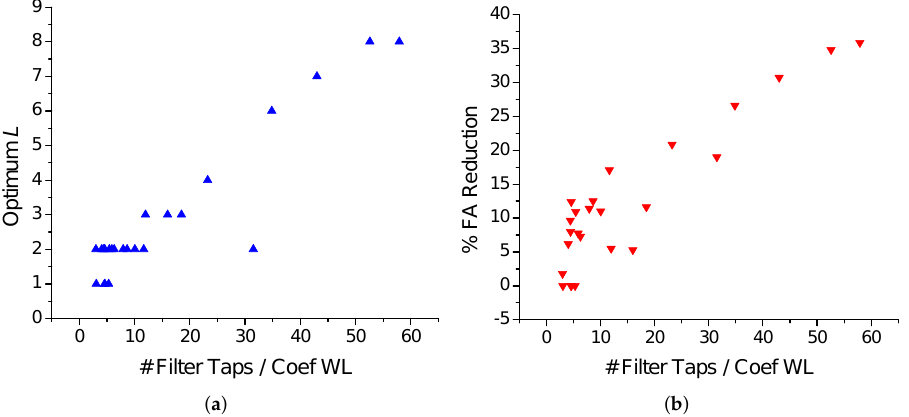
Figure 10. Relationship between ( a ) optimum L and “# Filter Taps/Coef WL” and ( b ) % FA reduction and “# Filter Taps/Coef